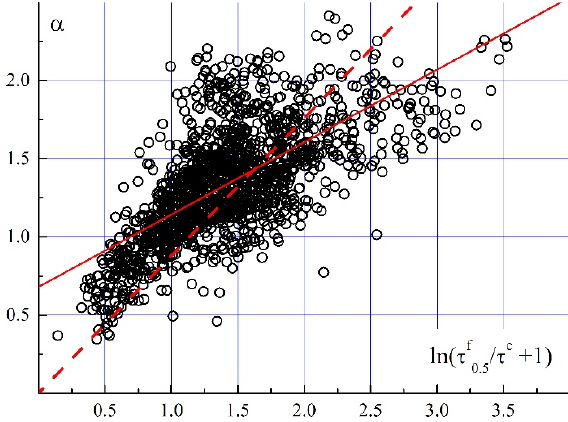
Figure 2. Correlation dependence between the α exponent and the /τ c ) according to measurements in Barentsburg. The solid ratio ( τ f 0 . 5 line shows the unconstrained linear regression, and the dotted line shows the regression through the origin